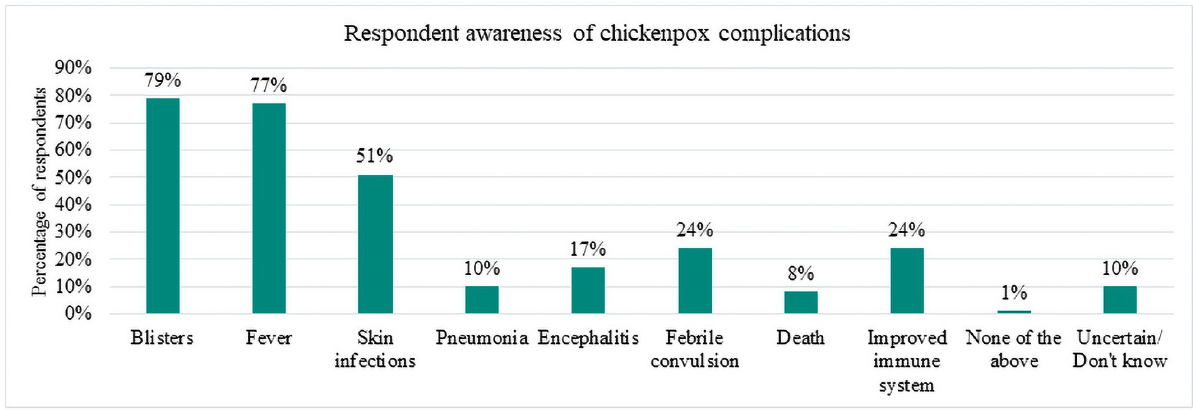
Fig 1. Bar chart showing percentage of overall respondents aware of different varicella complications (n = 2212).